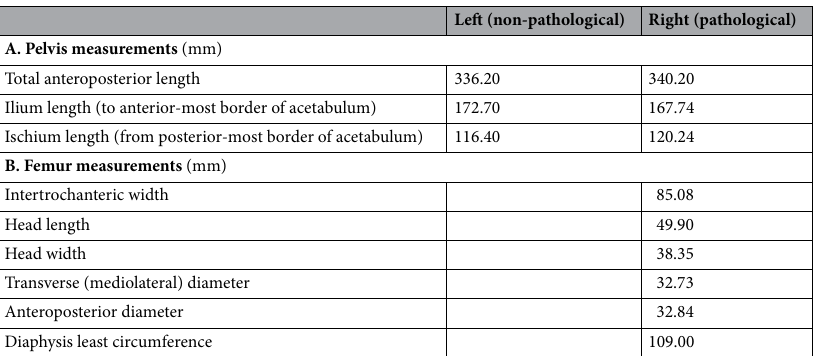
Left (non-pathological) Right